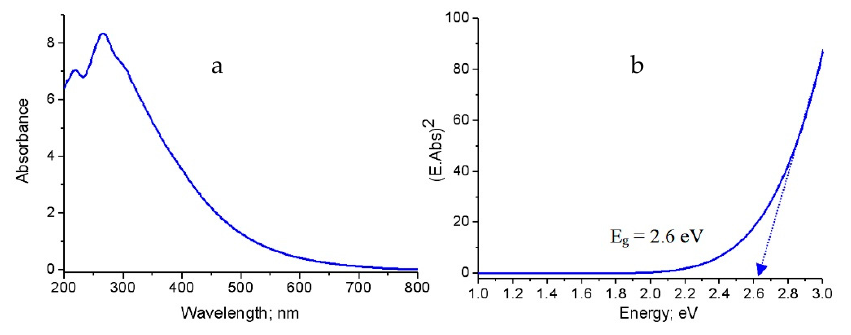
Figure 9. The prepared nanocomposite NC-1: ( a ) Absorbance spectrum and ( b ) Band gap energy.